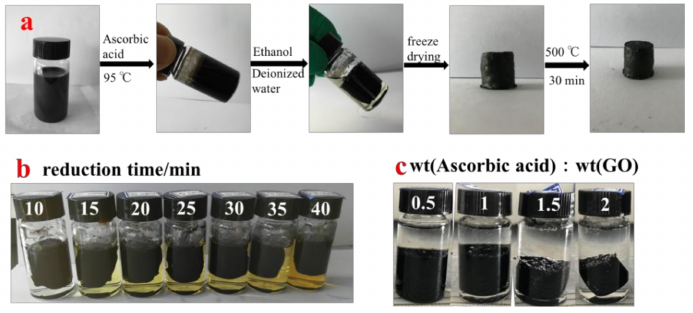
Figure 1. ( a ) Illustration of the synthesis process of graphene/CNTs ; ( b ) different reduction time; ( c ) different mass ratio of ascorbic acid and graphene